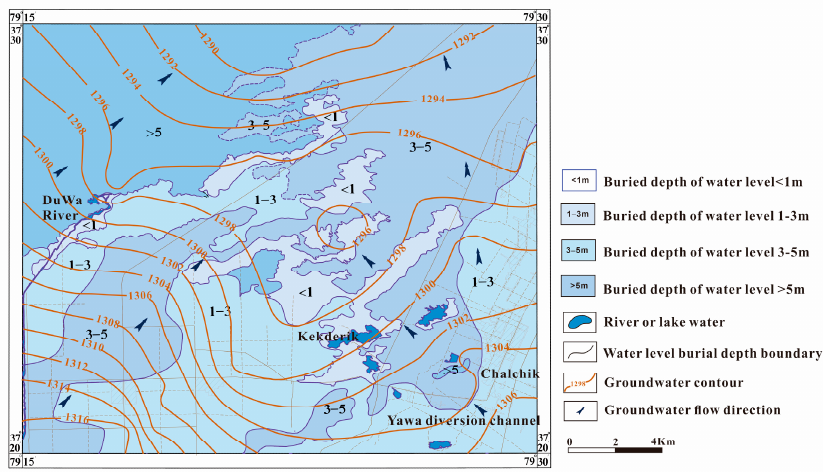
Figure 2. Contour map of phreatic water depth and water level.